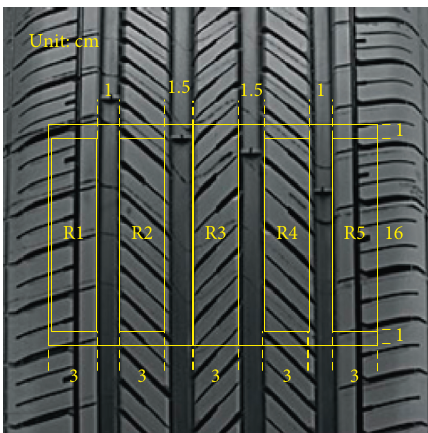
Figure 3: The actual tire-to-pavement